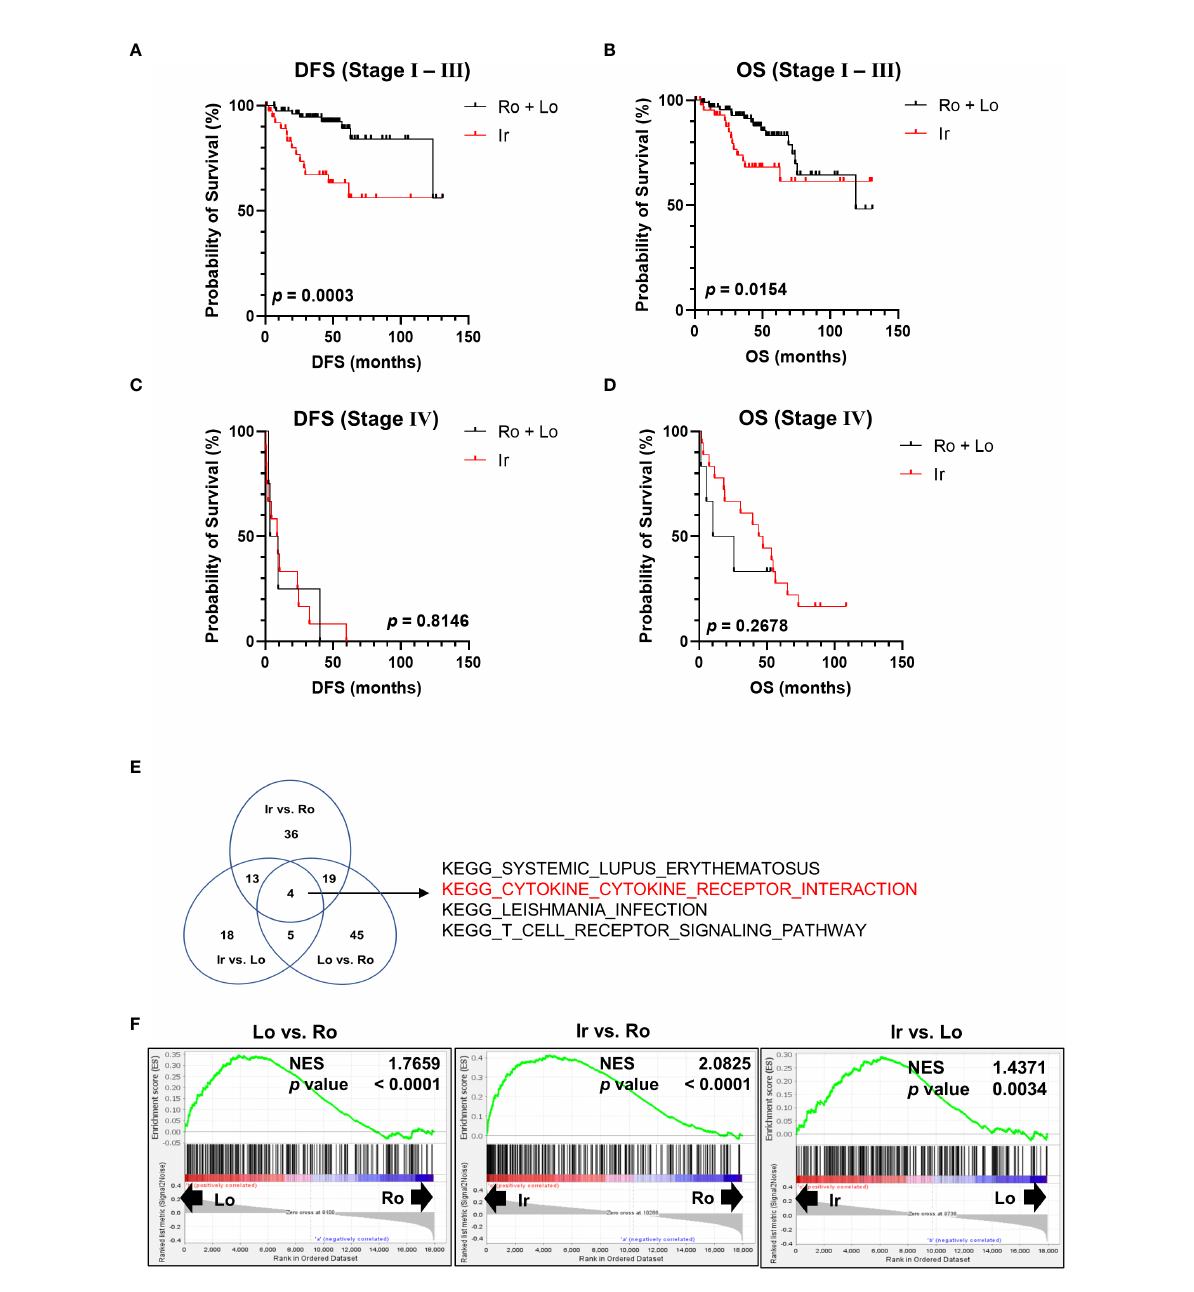
FIGURE 2 Genomic pro fi le comparison between each RM. (A, B) Comparison of disease-free survival (DFS) and overall survival (OS) between the irregular and round plus lobular type RM in patients with stage I, II, and III ccRCC. (C, D) Comparison of DFS and OS between irregular type and round plus lobular type RM in patients with stage IV ccRCC. (E, F) Comparison of all three RM types (irregular vs. round type, irregular vs. lobular type, and lobular vs. round type) between stages I, II, and III using Gene Set Enrichment Analysis and Kyoto Encyclopedia of Genes and Genomes (KEGG) gene sets. (E) Venn diagram showing the number of gene sets that were signi fi cantly positively enriched in the left-hand type of each comparison. (F) Normalized enrichment score (NES) of “ KEGG CYTOKINE-CYTOKINE RECEPTOR INTERACTION ” in each comparison